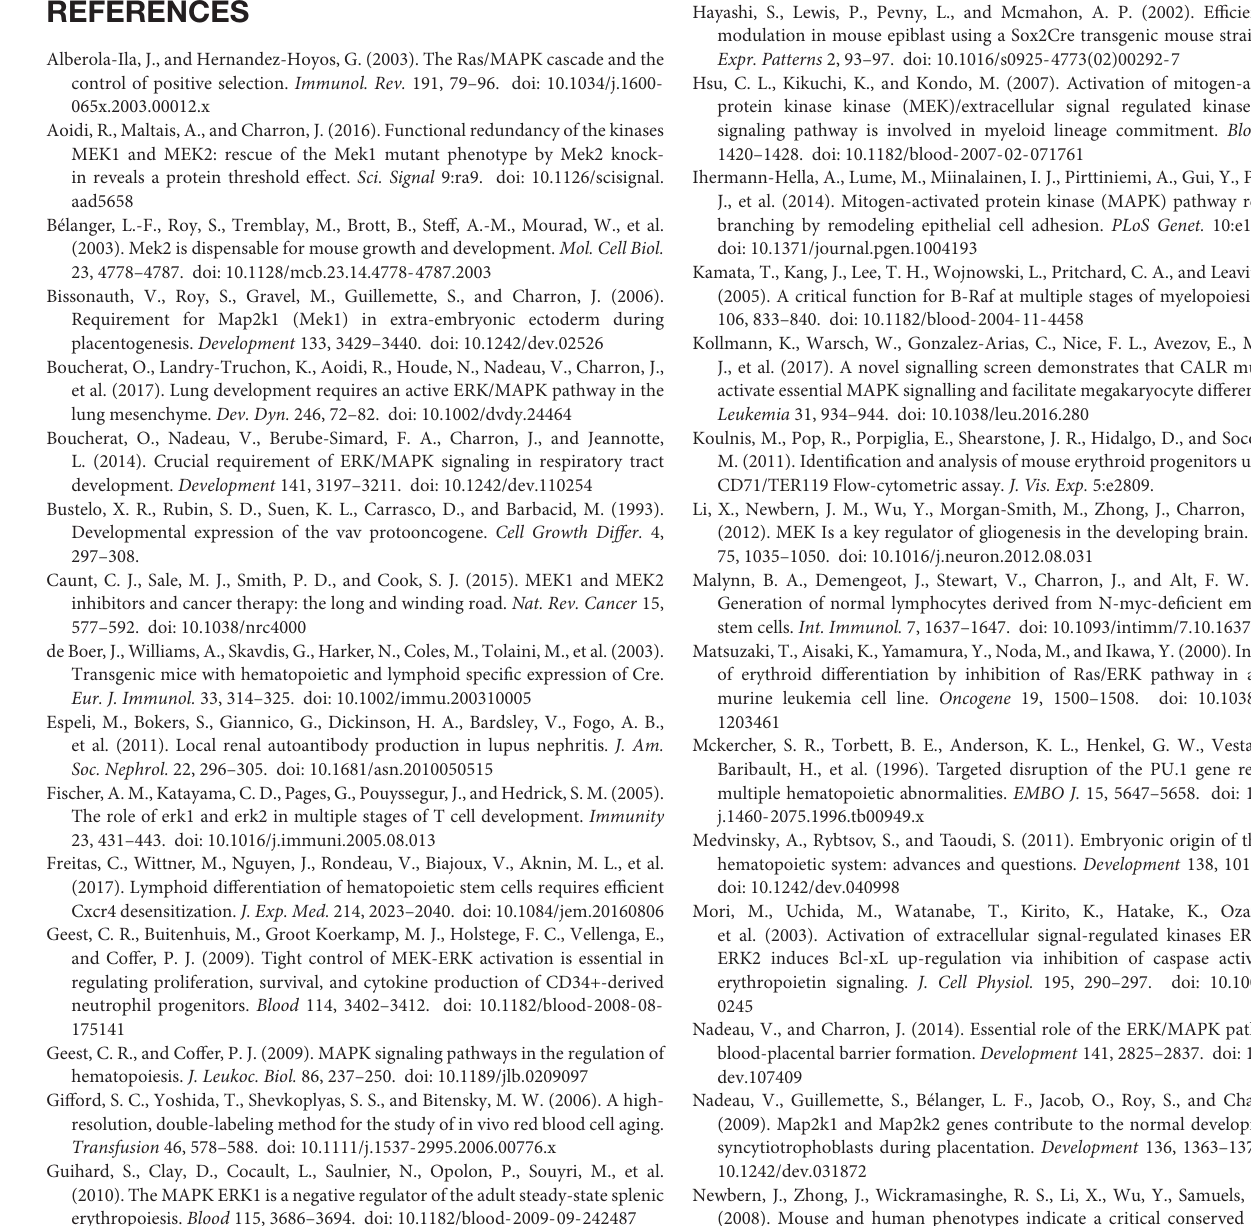
Supplementary Figure 2 | Numbers of HSCs and multipotent HSC progenitors in spleen from 1 Mek1 mutants. (A–L) Absolute numbers of LSK ( A